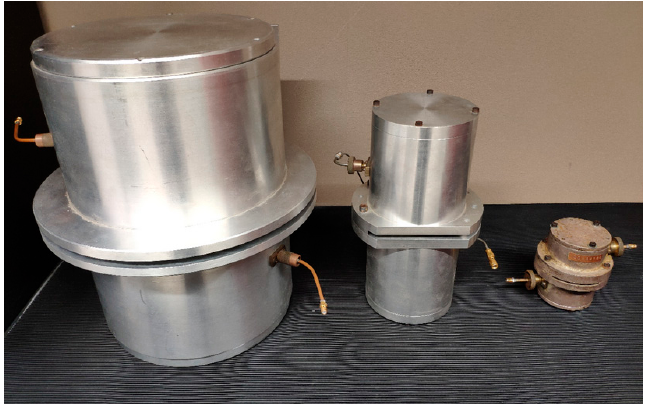
Figure 3. The resonant cavities used for dielectric characterization for Epson paper.